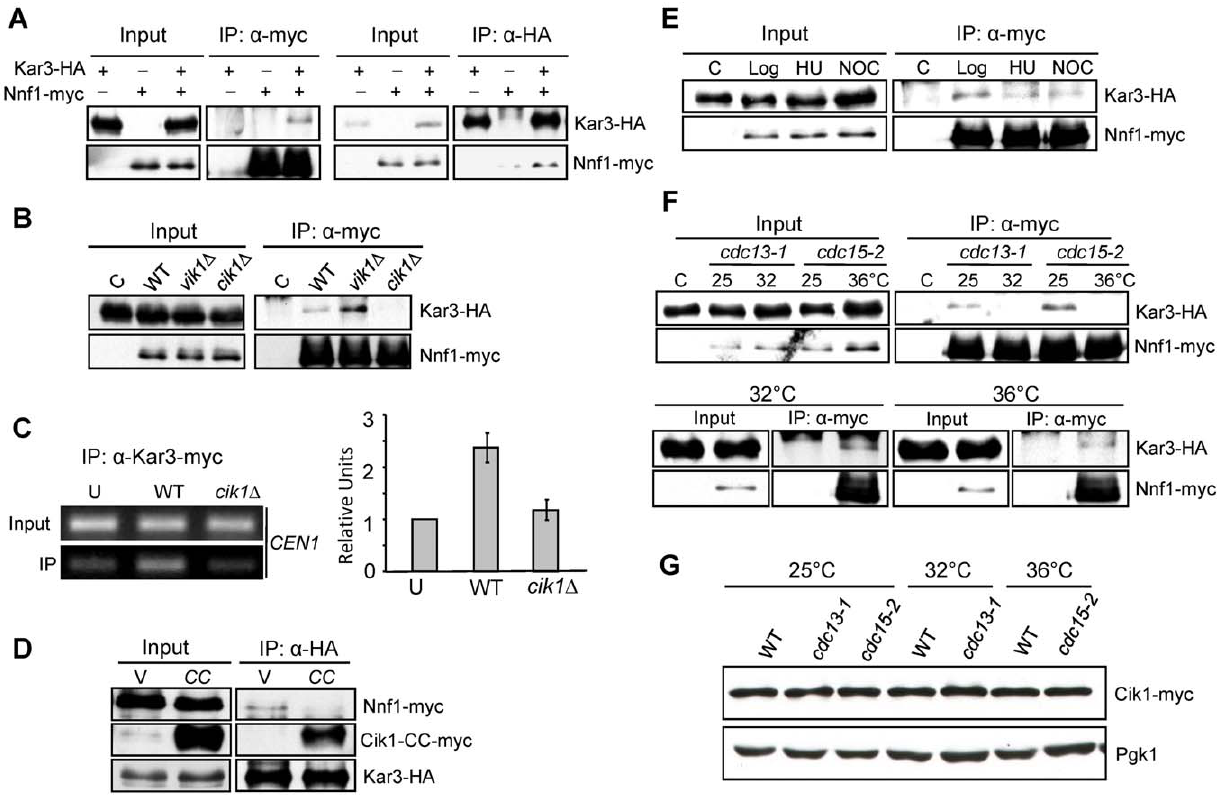
Figure 6. Kar3–kinetochore interaction is Cik1-dependent and cell cycle–regulated. A. Kar3 interacts with Nnf1 in vivo . KAR3-3HA NNF1- 13myc cells in mid-log phase were collected to prepare cells extracts. The extracts were immunoprecipitated with either anti-HA or anti-myc antibody. The protein levels in the whole cell extracts and precipitates are shown after Western blotting with anti-HA and anti-myc antibodies. B. The interaction of Kar3 with Nnf1 depends on Cik1. WT, cik1 D , and vik1 D cells carrying KAR3-3HA NNF1-13myc were grown to mid-log phase. The extracts were immunoprecipitated with anti-myc antibody. The protein levels of Kar3-3HA and Nnf1-13myc are shown after Western blotting. C. cik1 D mutant cells show deceased Kar3-centromere interaction. KAR3-13myc and cik1 D KAR3-13myc cells in log phase were collected for ChIP assay with anti-myc antibody. The PCR products with primers specific for CEN1 are shown in the left panel and the quantified data from three repeats are shown in the right. ‘‘U’’ is an untagged strain used as a control. D. Overexpression of CIK1-CC disrupts Kar3-Nnf1 interaction. KAR3-3HA NNF1-13myc cells with a vector (V) or a P GAL CIK1-CC plasmid (CC) were incubated in galactose medium for 3 hrs. The protein samples were prepared and the Kar3-Nnf1 interaction was analyzed as described in A. E. Kar3 interacts with Nnf1 in HU- and nocodazole-arrested cells. KAR3-3HA NNF1-13myc cells in mid-log phase were divided into three portions as untreated (Log), HU (200 mM)- and nocodazole (NOC, 20 m g/ml) - treated samples. After 3 hr treatment, the samples were analyzed for Kar3-Nnf1 interaction as described. KAR3-3HA cells was used as a negative control and marked as ‘C’. F. Kar3 dissociates from Nnf1 in cdc13-1 and cdc15-2 arrested cells. cdc13-1 and cdc15-2 cells with KAR3-3HA and NNF1-13myc were grown to mid-log phase at 25 u C. Then temperature was shifted to 32 u C (for cdc13-1 ) and 36 u C (for cdc15-2 ). After 2 hr incubation, the cells were collected and the protein samples were prepared and analyzed for Kar3-Nnf1 interaction. This interaction in cdc13-1 and cdc15-2 mutant cells incubated at permissive and non- permissive temperatures is shown in the top panel. The Kar3-Nnf1 interaction in WT cells after incubation at 32 u C and 36 u C for 2 hr is shown at the bottom panel. G. The Cik1 protein levels at different cell cycle stages. WT, cdc13-1 , and cdc15-2 cells with CIK1-13myc were grown to mid-log phase at 25 u C, and then shifted or 32 u C (for cdc13-1 ) and 36 u C (for cdc15-2 ) for 2 hrs. The cells were harvested to prepare protein samples. Cik1 protein levels are shown after Western blotting. Pgk1 proteins level was used as a loading control.